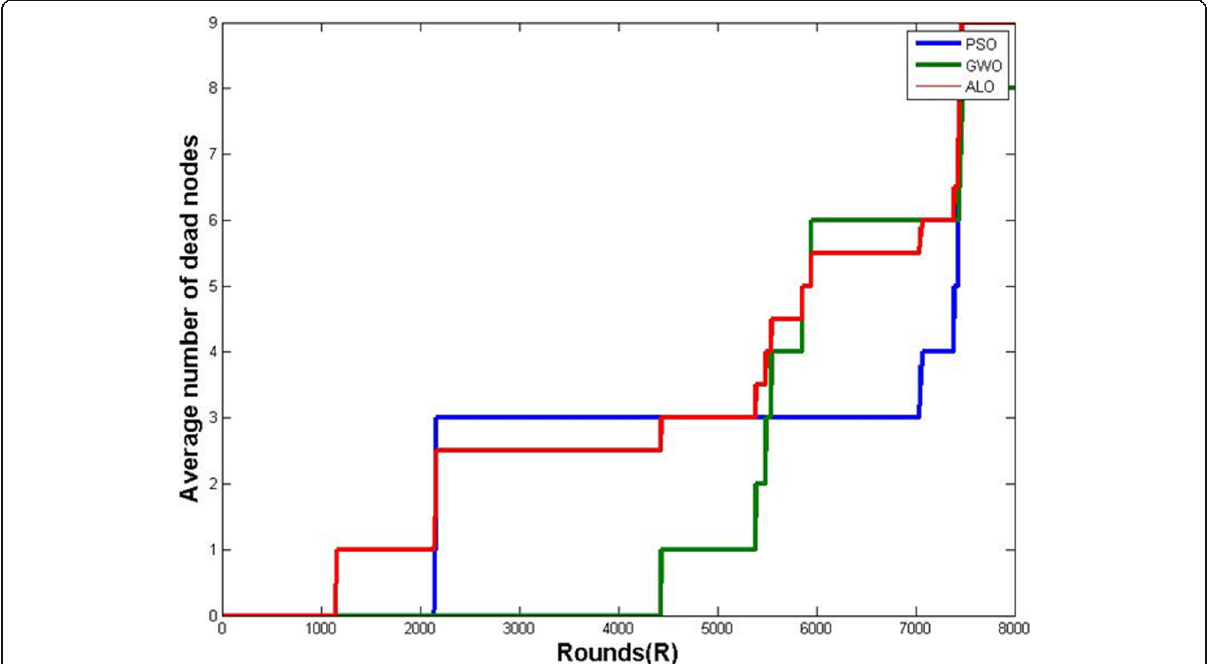
Fig. 3 Network lifetime for PSO, ALO, and GWO for WBAN